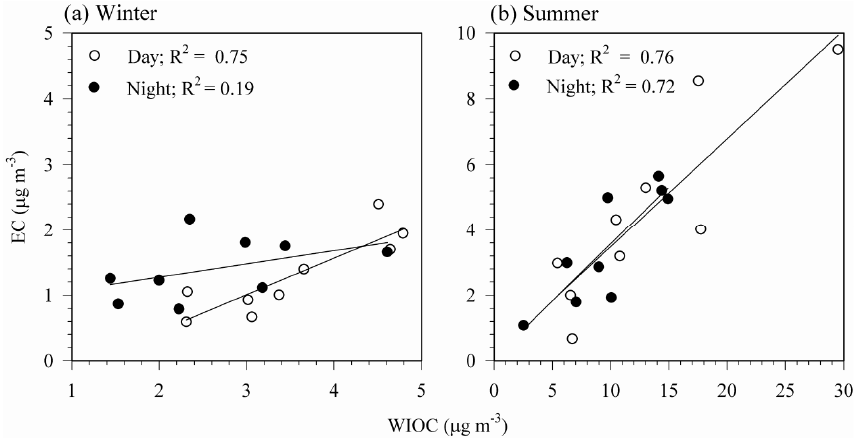
Fig. 4. Scatter plots between water insoluble organic carbon (WIOC) and elemental carbon (EC) during (a) winter and (b) summer seasons showing a linear